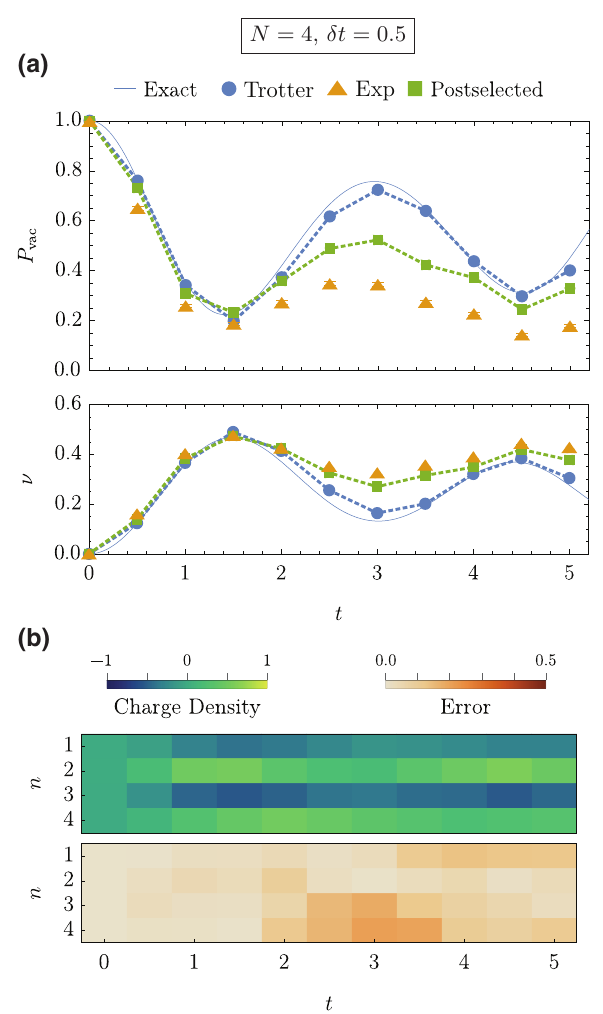
FIG. 6. Experimental results for N = 4 and δ t = 0.5. (a) The upper plot shows fluctuation in the bare-vacuum population, P vac ( t ) , while the lower plot shows the particle-number density, ν( t ) . (b) The upper plot shows the local charge density Q measured in the experiment after postselection, while the lower plot shows its deviation from